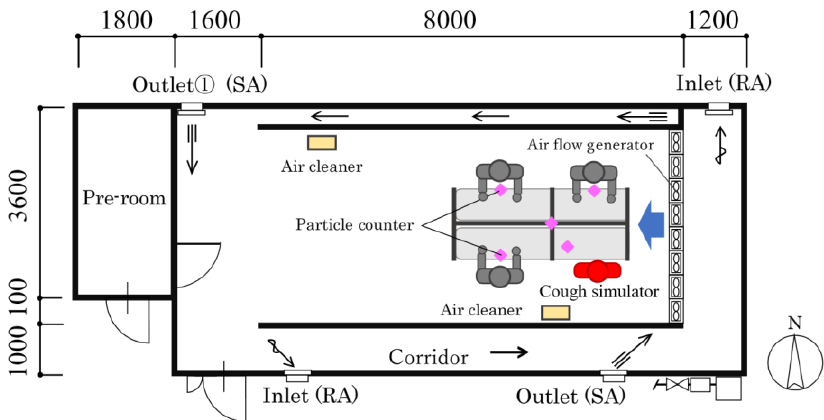
Figure 1. Plan of the artificial climate chamber with an airflow generator.